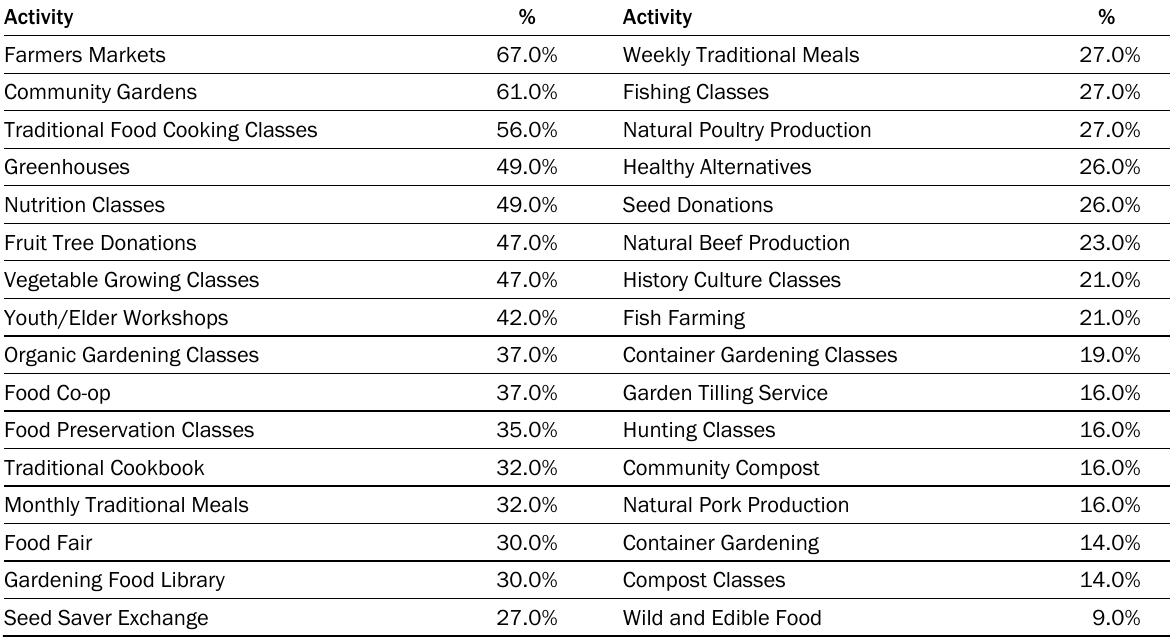
Table 2. Activities or Projects that You Would Like to See in Your Community, n =43 Activity Farmers